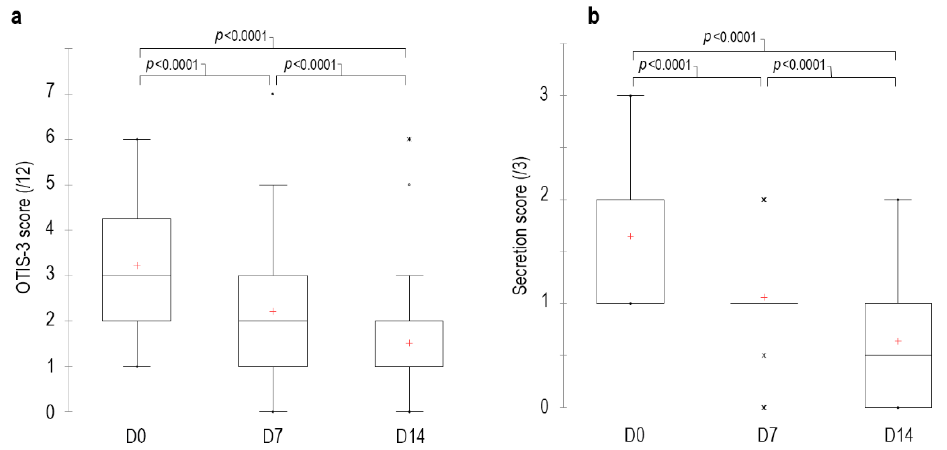
Figure 3. Kinetics of the OTIS-3 ( a ) and secretion ( b ) scores in dogs with erythemato-ceruminous otitis externa cleaned with the tested ear cleanser at different time points during the study. Explanation for the box and whisker plots: the top of each box represents the third quartile, the red cross (+) in the middle is the mean, the horizontal bar in the box is the median, the bottom of the box is the first quartile and the upper and lower whiskers represent minimum and maximum scores. Dots were considered as outliers.